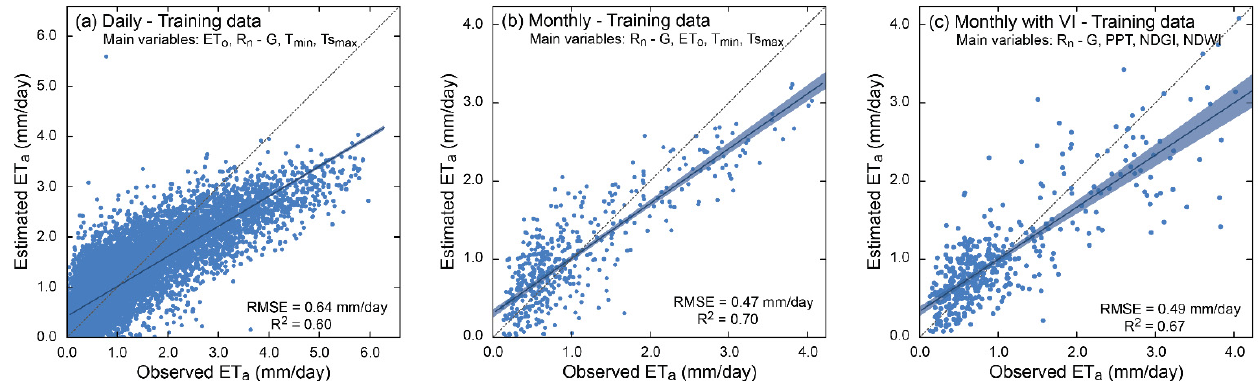
Figure 8. Regression formulae for the training data set (including the data from the seven training sites). ( a ) Daily estimates; ( b ) monthly estimates only taking into account meteorological data; ( c ) monthly estimates considering meteorological data and VIs. Each panel includes the main variable selected for the construction of each formula, the RMSE, and the R². The blue band corresponds to the 95% confidence interval.